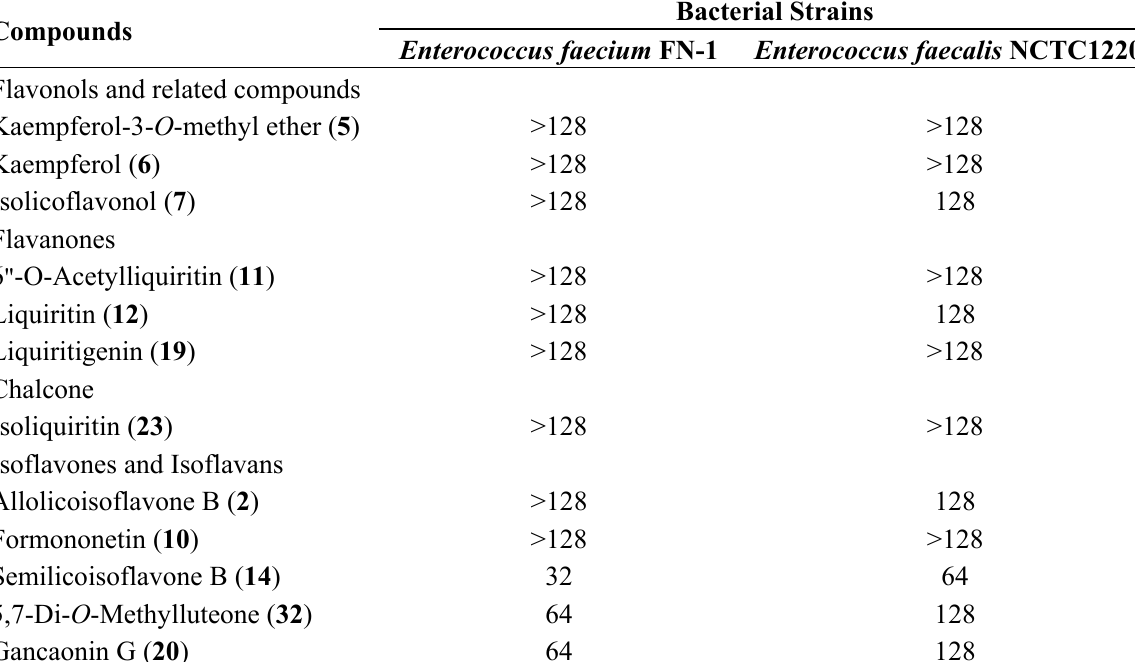
minimum inhibitory concentrations ( μ